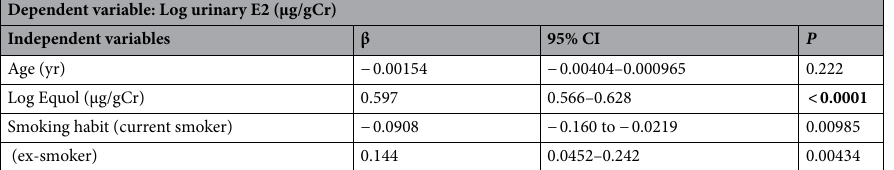
Table 2. Analysis of covariance of the association between urinary estradiol and equol levels. CI: confidence interval. Analysis of covariance was conducted for log urinary E2 as dependent variable with independent variables (log equol, age and smoking). Tobacco use was coded as 1 = non-smoker, 2 = current smoker, and 3 = ex-smoker. Model fitness: R 2 = 0.751. IQR increase in equol (17.6 μg/gCr to 329 μg/gCr; 18.9-fold) was associated with 5.74-fold higher urinary E2 level.